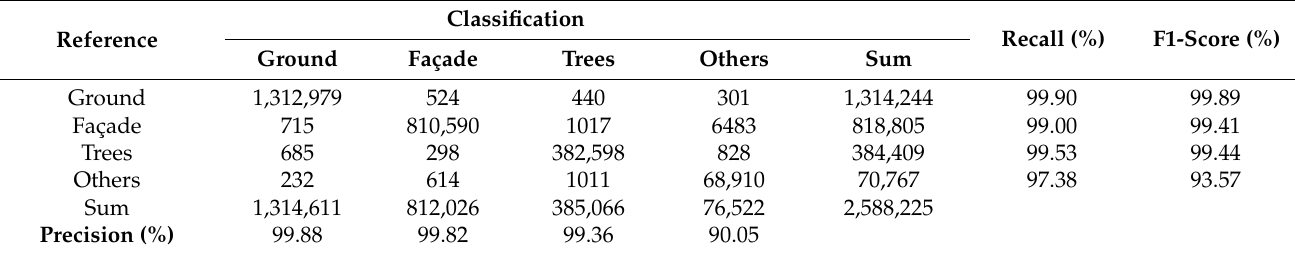
Figure 6. Classified point cloud using sixteen features with classification errors in black bounds. Table 4. Confusion matrix and accuracy metrics of classification results.